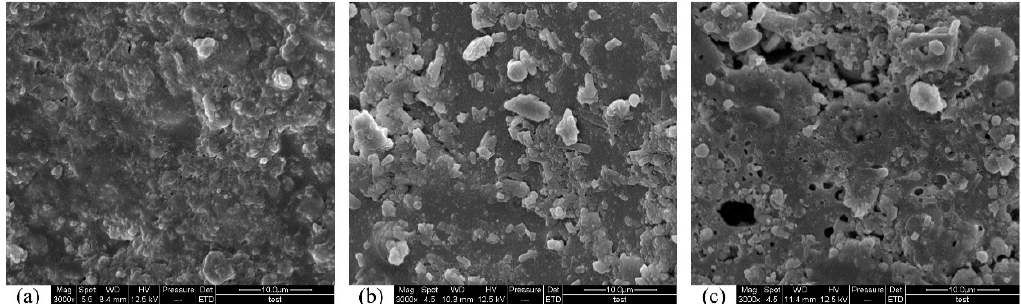
Figure 8. SEM images of surface of lightweight aggregate PC specimens immersed in pH 0.5 sulfuric acid solution: ( a ) 0 d immersion; ( b ) 30 d immersion; ( c ) 50 d immersion.